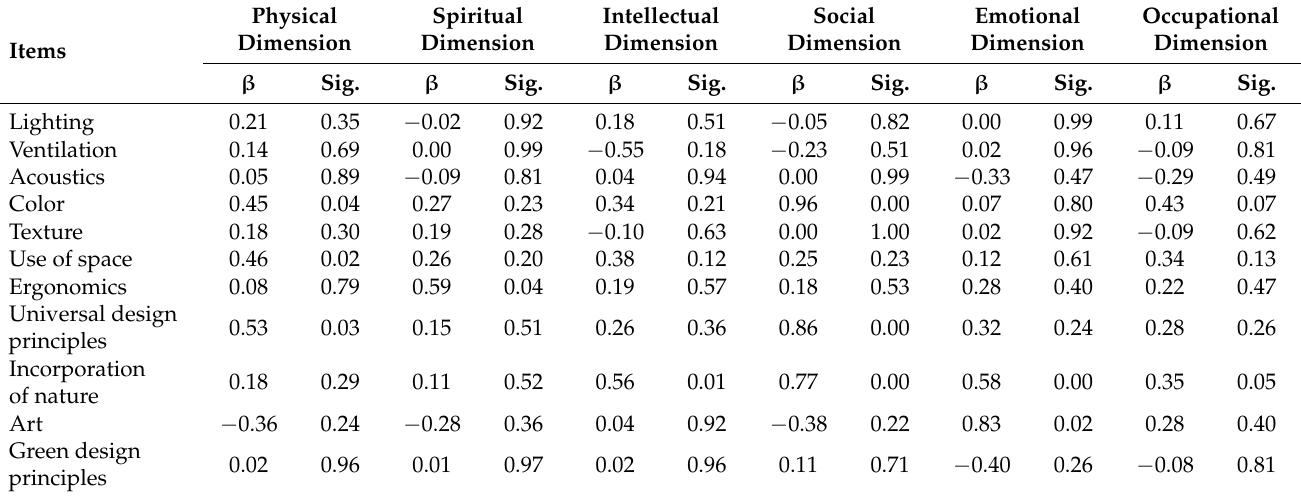
Table 6. Regressions